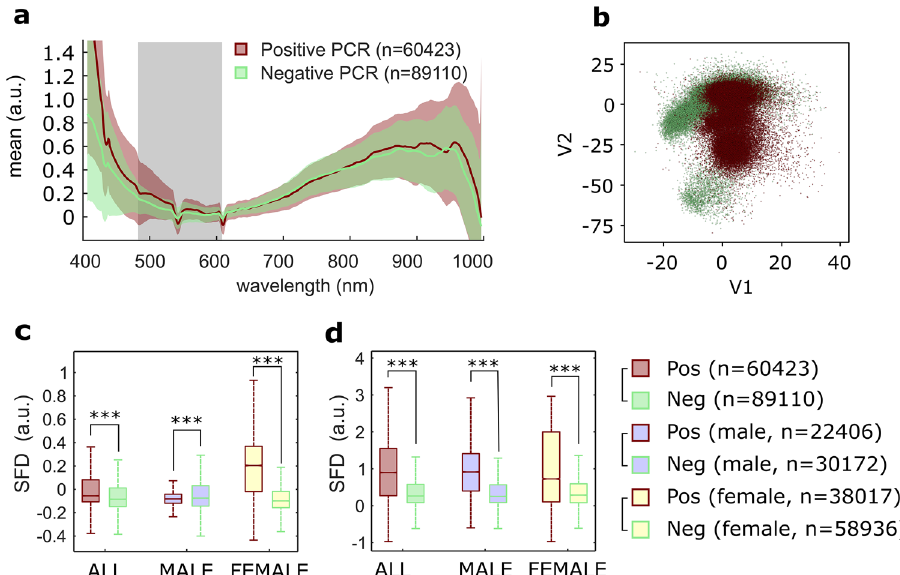
Figure 4. Experiment 3: Spectral information from SARS-CoV-2 in fresh saliva specimens. ( a ) Mean (± std) of the pseudo-absorbance pixel spectra from fresh saliva samples. Positive (pos) and negative (neg) cases were determined by PCR test. ( b ) Scatterplot of the two latent variables obtained in partial least square-discriminant analysis (PLS-DA) Model 1 from the pixel spectra. Positive and negative PCR tests are brown and green dots respectively. ( c ) Value of the spectral feature descriptor (SFD) obtained between 483 and 610 nm (grey band in ( a )) for positive and negative cases. ( d ) Value of the spectral descriptor SFD obtained between 407 and 470 nm for positive and negative cases. ( c,d ) Both panels include differentiation between male and female pixel sets. ***p-value = 0 using the Wilcoxon rank sum test. Outliers were removed for